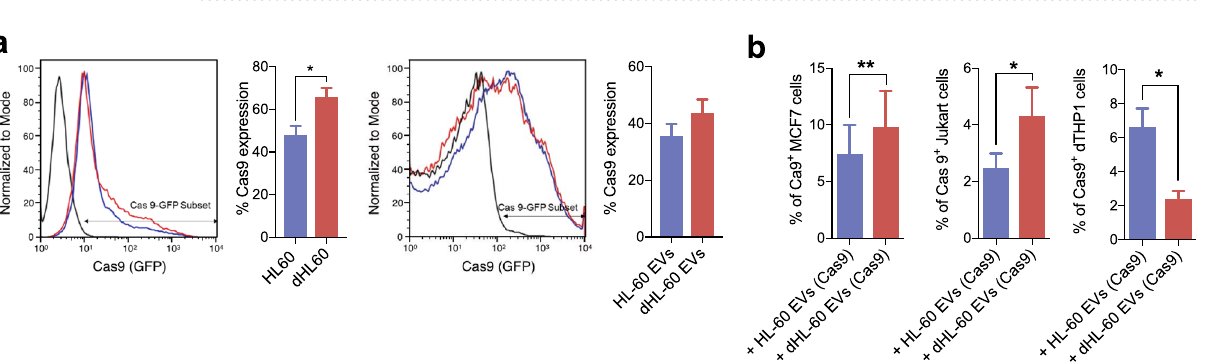
Figure 4. The delivery of miRNA-16 using dHL-60 cell-derived EVs. ( a ) Left panels, fluorescence levels of the miRNA-16 precursor in the HL-60 and dHL-60 cells. Right panels, fluorescence levels of the miRNA-16 precursor in EVs derived from the HL-60 and dHL-60 cells. ( b ) Left panels, fluorescence levels of the miRNA- 16 mimic in the HL-60 and dHL-60 cells. Right panels, fluorescence levels of the miRNA-16 mimic in EVs derived from the HL-60 and dHL-60 cells. ( c ) The effects of EVs on the proliferation of the MCF-7, Jurkat, and dTHP-1 cells. ( d ) The effects of EVs on expressions of iNOS and arginase in MCF-7, Jurkat, and dTHP-1 cells. ( e ) The expression of iNOS in the dTHP-1 cells exposed to the HL-60 and dHL-60 cells. All data represent three independent experiments; mean ± SEM. *P < 0.05; **P < 0.01; ***P < 0.001.